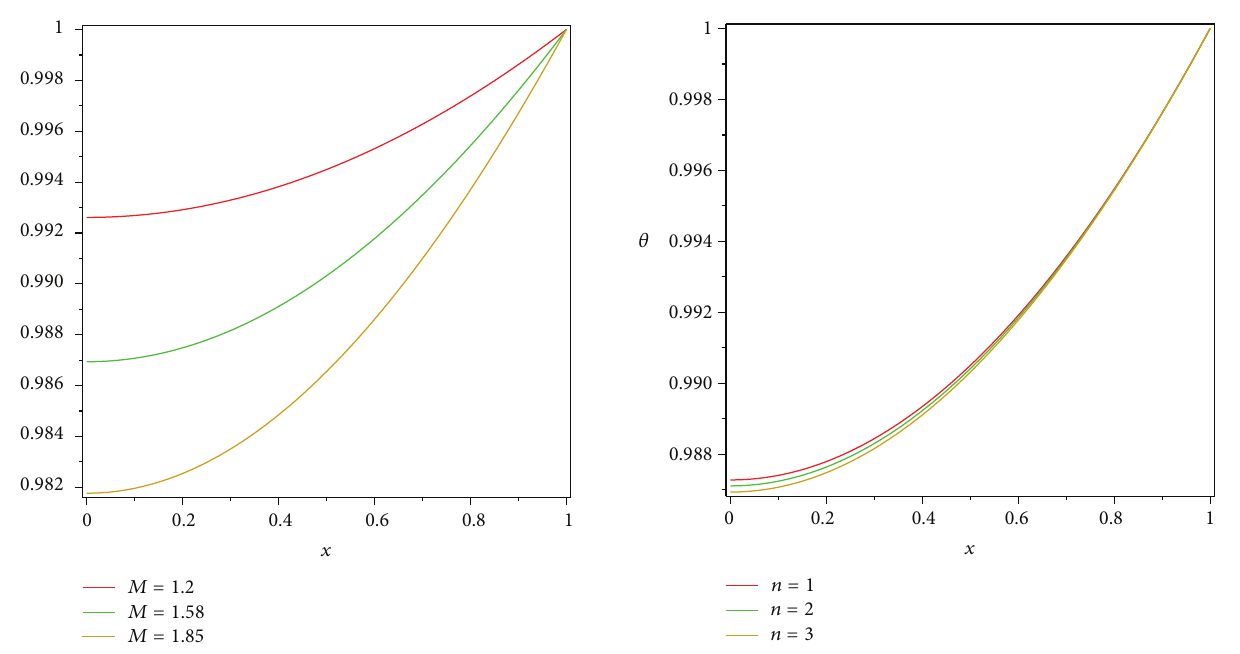
Figure 9: Temperature 𝑓(𝑥) = 1 , 𝑛 ̸= 𝑚 as given in solution (41) in a fin with varying values of 𝑛 .